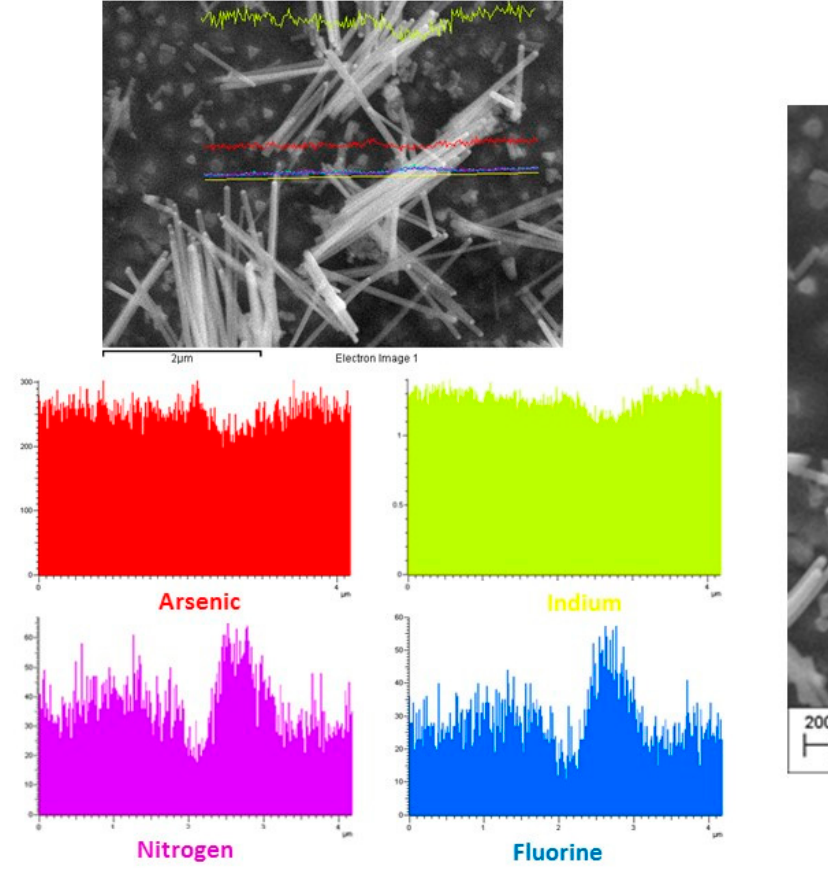
Figure A2. Nanowires (NW).